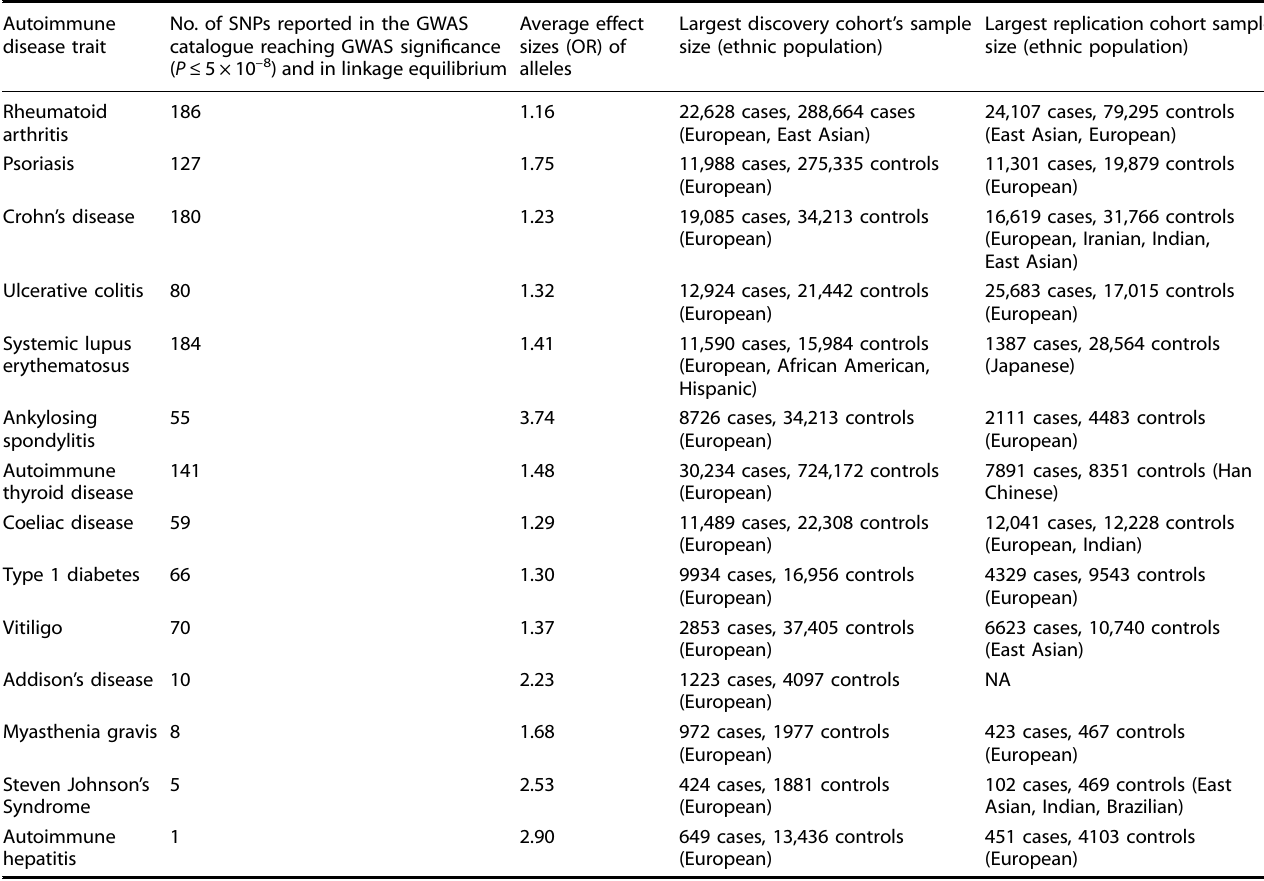
Table 3. Genetic variants associated with common autoimmune disease traits. Autoimmune disease